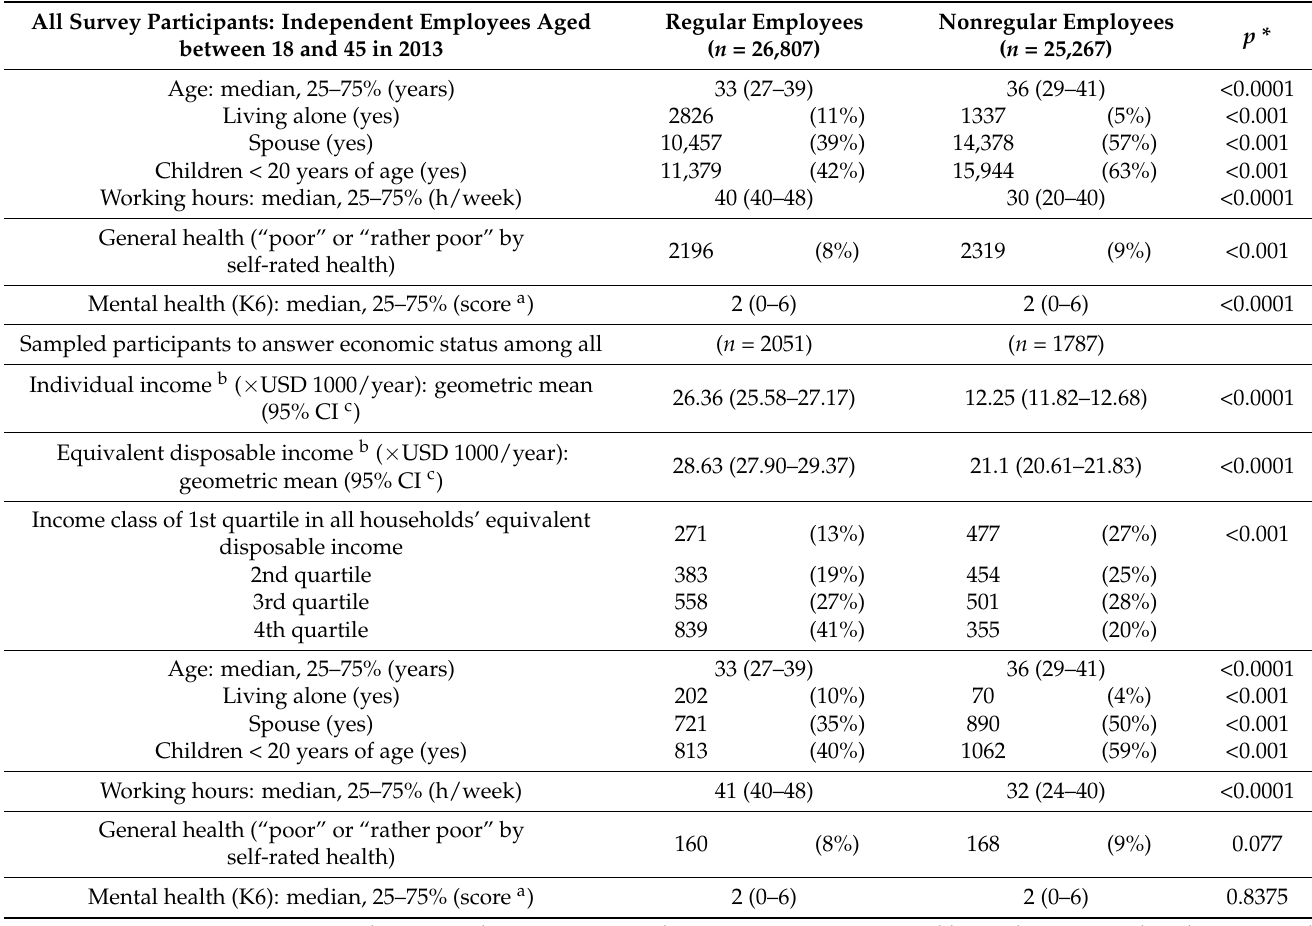
Table 2. Basic characteristics of female employees (upper: all survey participants with and without income information; lower: participants with income